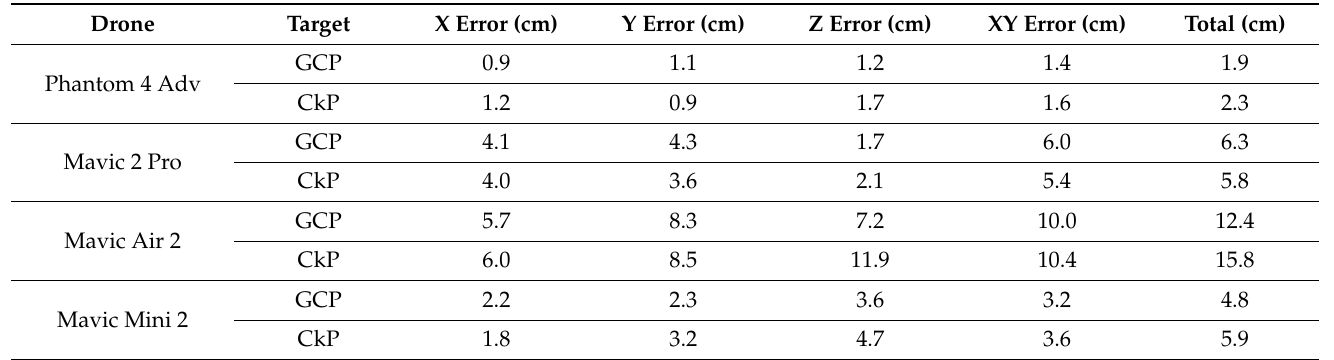
Table 7. Residuals for 60 m AGL flights for all the UAS models. Total represents the total error of the 3